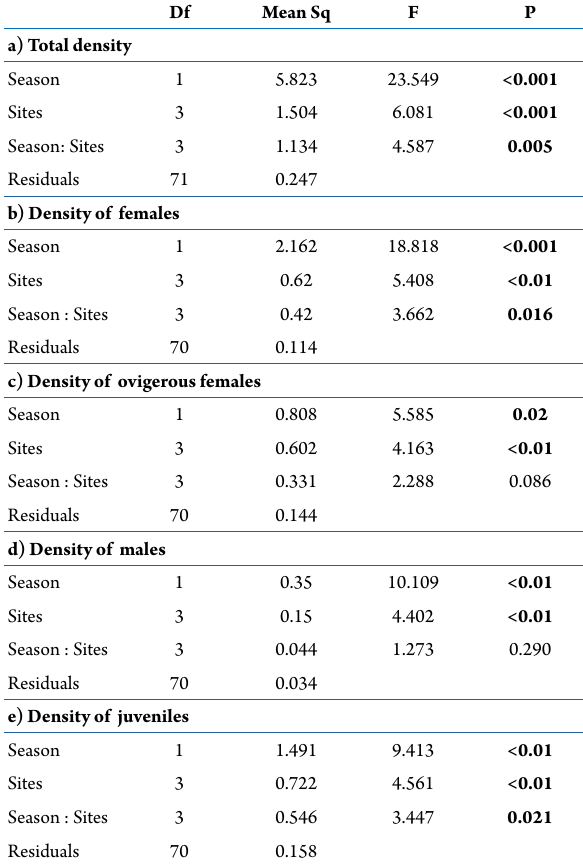
Table 4. ANOVA results for Sunamphitoe pelagica for comparisons of amphipod densities between sites and seasons. ( a ) Total density; ( b ) density of females; ( c ) density of ovigerous females; ( d ) density of males and ( e ) density of juveniles . Bold font indicates significant P values.